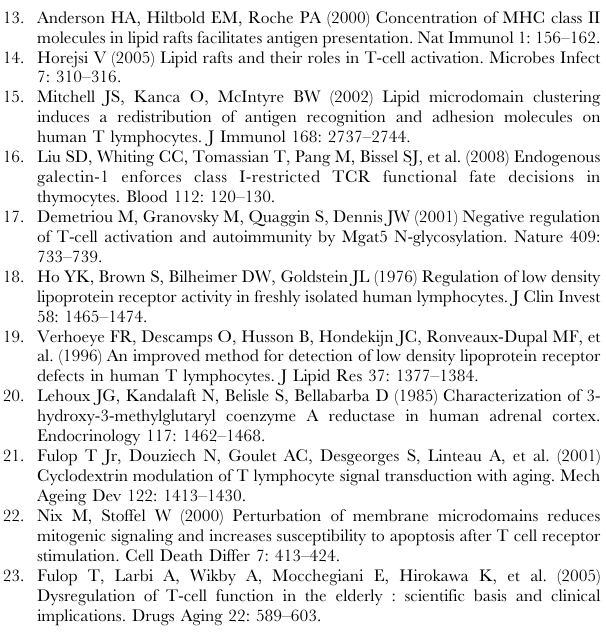
Figure S1 Squalene administration leads to accumula- tion of membrane cholesterol in several lymphocyte subsets. F1 hybrid mice (n= 5/group) were injected i.p. (dark plots) or not (light plots) with a single dose of squalene (180 m g/ mouse) and 7 days later splenocytes were individually stained for CD8, CD22.2, CD19, or CD11c, and co-stained with CD3 and Filipin III. Shown are the percent values 6 SD and MFI values of Filipin III 6 SD collected among 100–800 cell events in gated populations from one of two representative experiments. Values to the left correspond to untreated mice, and values to the right correspond to squalene treated mice. Figure S2 Effect of recurrent administration of squa- lene on the cholesterol metabolism. (A) Serum lipid electrophoresis of F1 mice treated i.p. with 4 doses of squalene (red line) given once a week (180 m g/dose/mouse) (lanes 1–2), or untreated mice (lanes 3–4) as analyzed 7 days after the last squalene injection. Shown are the LDL, VLDL, and HDL serum fractions of cholesterol from 4 of 10 mice analyzed. The electrophoretic bands were scanned by densitometry and quanti- fied using the SCION analysis software (right panel). Of note, a recurrent squalene treatment resulted in increased HDL serum fraction. (B) Liver accumulation of cholesterol in individual untreated or squalene treated (180 m g/mouse) F1 mice analyzed 7 days after the last squalene injection by staining frozen liver sections with Sudan IV and hematoxylin (n =5 mice/group). Upper panel shows the presence of cholesterol (reddish spots) in a sample of fat tissue (control cholesterol staining). Lower left panel, untreated F1 mouse at X40 magnification. Lower right panel, F1 mouse treated with 4 doses of squalene at X40 magnification. Of note, slight increase in cholesterol accumulation (reddish areas) was detected in mice treated with 4 doses. Shown is one representative liver section from each group of mice.